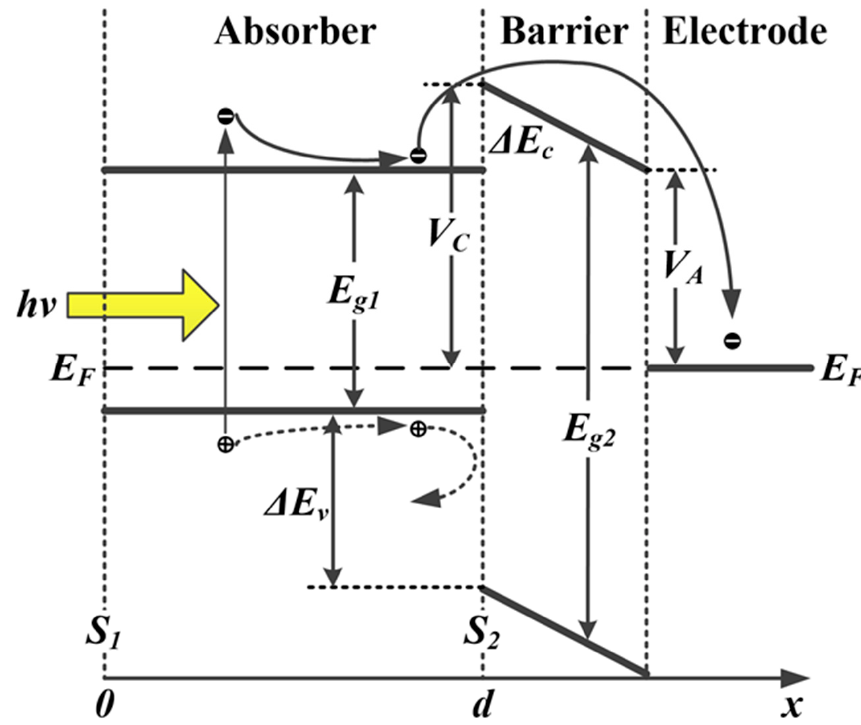
Figure 1. Band schematic of the solid-state photon-enhanced thermionic emission (PETE) converter. The (cid:1836) and (cid:1848) of the solid-state PETE converter are derived based on the one-dimensional (cid:2868) (cid:3042)(cid:3030)